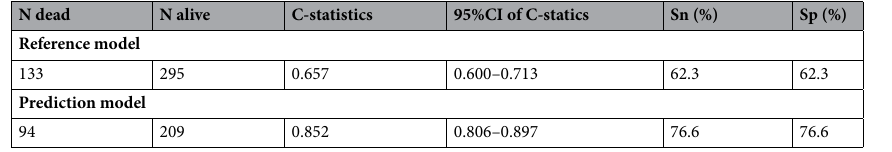
Table 5. Comparing of receiver-operator characteristic analysis of the models to evaluate the accuracy of predicted probability (p) for the 72-h mortality. N, number; CI, confidence interval; Sn, sensitivity; Sp, specificity.